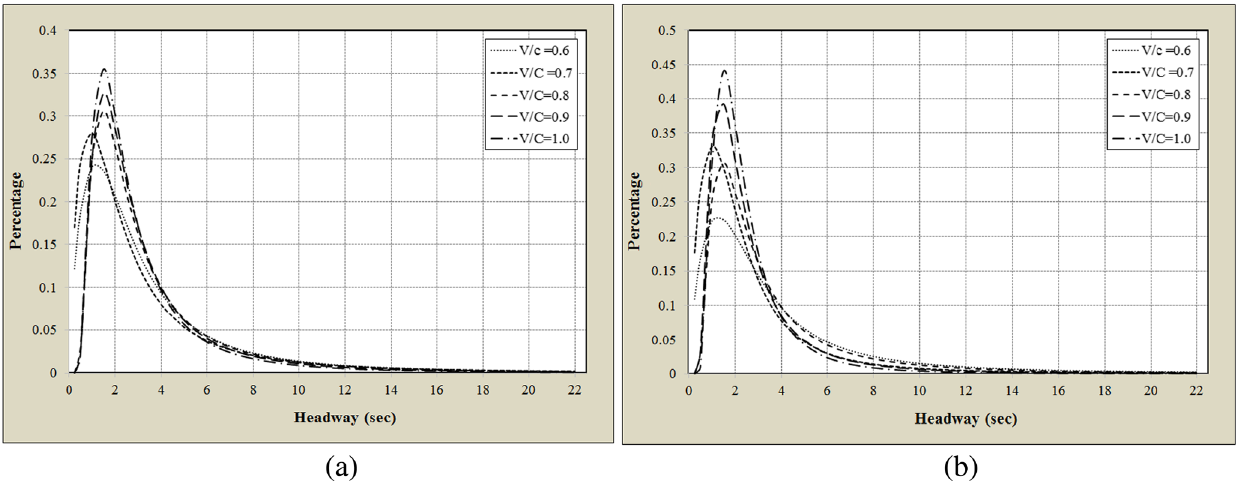
Fig. 4 Probability density functions of headways at different flow levels: a west bound traffic and b East bound